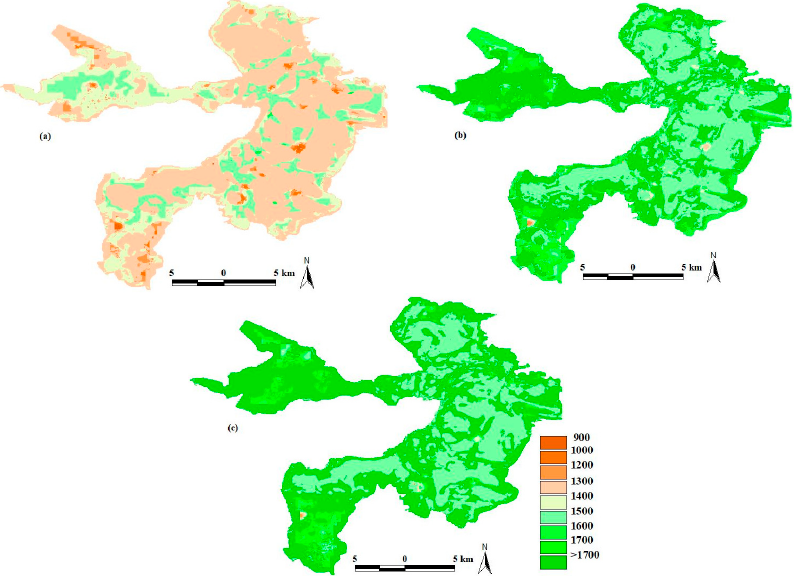
Figure 6. Evapotranspiration ( ET ) variation in Baiyangdian Lake under three different historical water levels: ( a ) the maximum water level (9.22 m, in 1965), ( b ) the water level wherein the lake dried up (6.37 m, in 1984) and ( c ) the maximum fractional vegetation cover ( F v ) (7.15 m, in 1998).